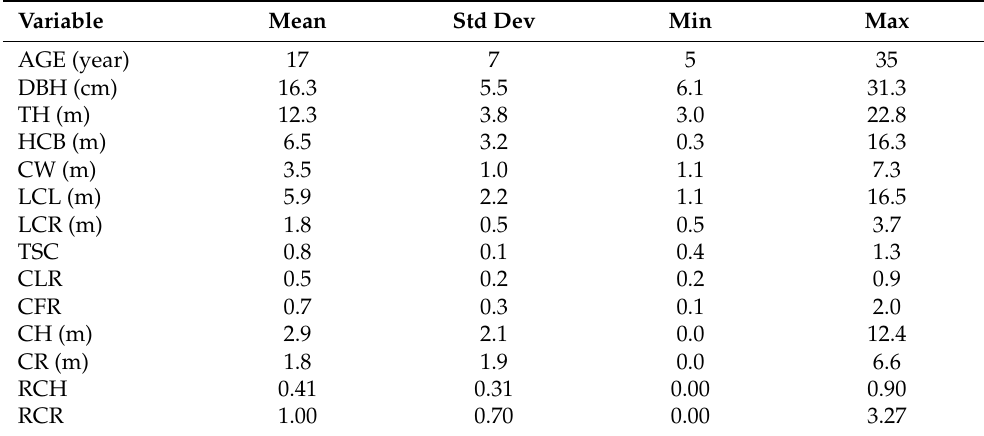
Table 1. Summary statistics of tree characteristic data for 340 sample trees.